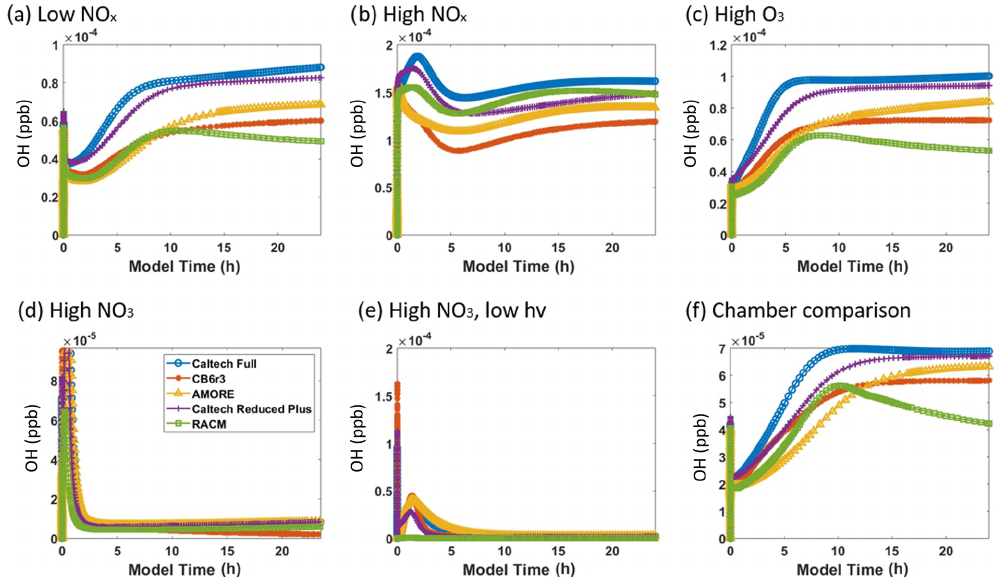
Figure 6. Box model predictions of the hydroxyl radical from multiple mechanisms (292K and 1000hPa) under the following conditions: